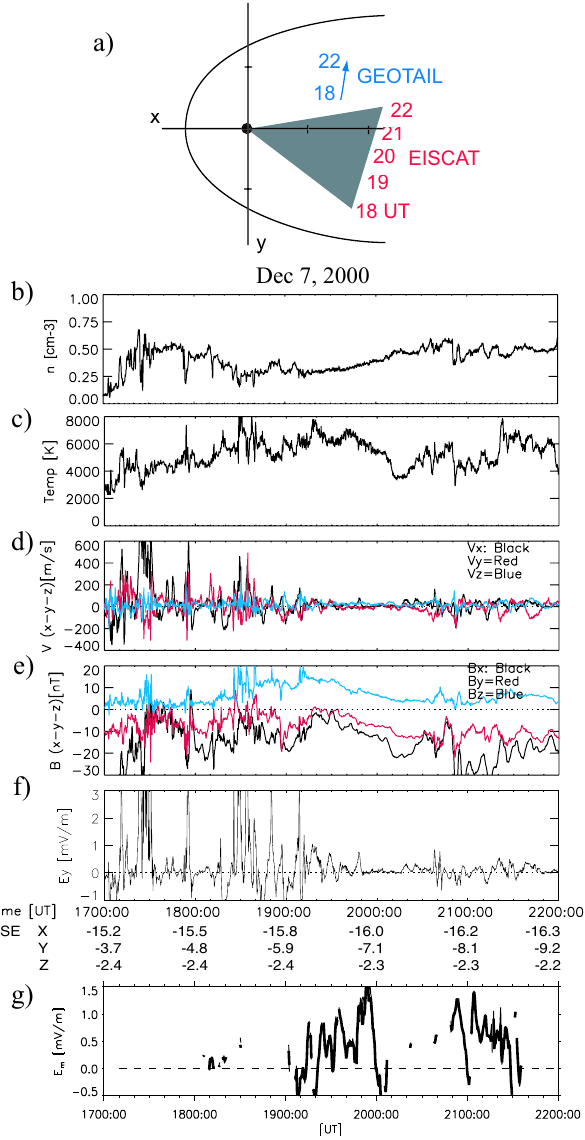
Fig. 11. ( a ) The Geotail trajectory and the sector the ESR data are obtained. (a-g) Geotail measurements in the nightside plasma sheet. ( b ) density, ( c ) temperature, ( d ) the three components of the ion bulk velocity, ( e ) the three magnetic field components, ( f ) the duskward electric field (V x · B z ) and ( g ) the reconnection rate estimated from the radar measurements.